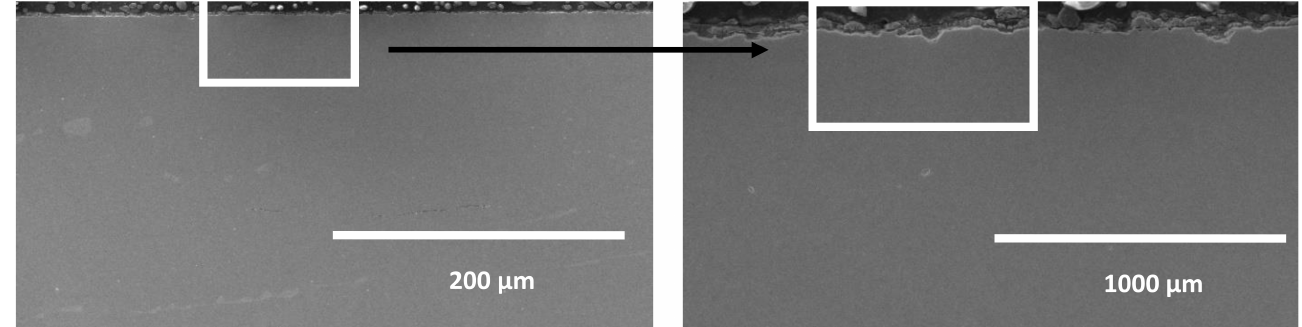
Figure 12. Cross section of L80-1 sample exposed to 65 ◦ C (a long sample).